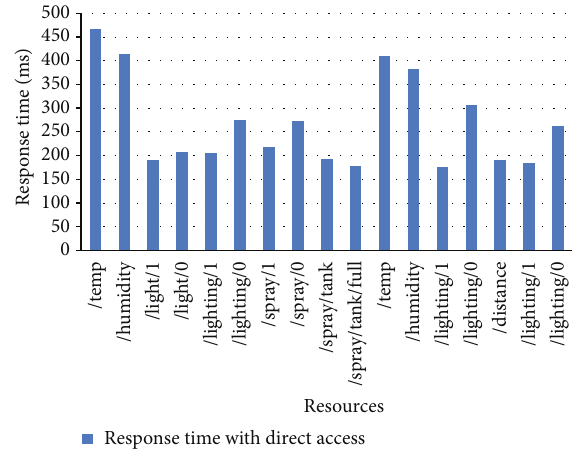
Figure 6: Response times of UAV resources with direct